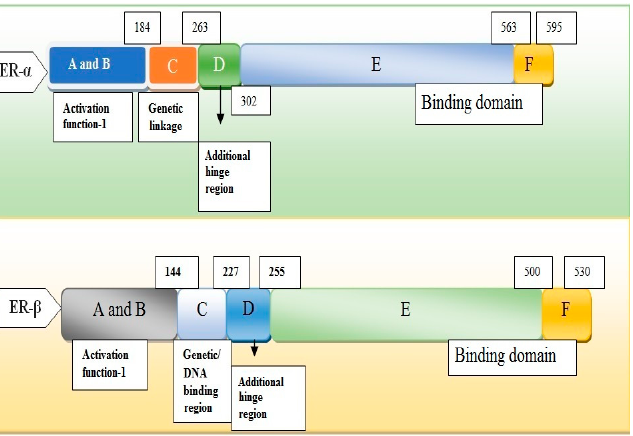
Figure 3. Genetic structure of receptors ER- α and ER- β shows activation regions A and B, genetic linkage region C, hinge region D, Ligand-binding domain E, and binding domain F [57]. Both have two different regions for their reaction (structural and functional). The transactivation domain of ER- α contains coactivation and co-repression. The hinge region in both receptors determines the conformational changes in the receptors. A modification in the transcriptional role can be achieved by the process of acetylation and methylation. ER- β is found to be weaker towards the corresponding function.